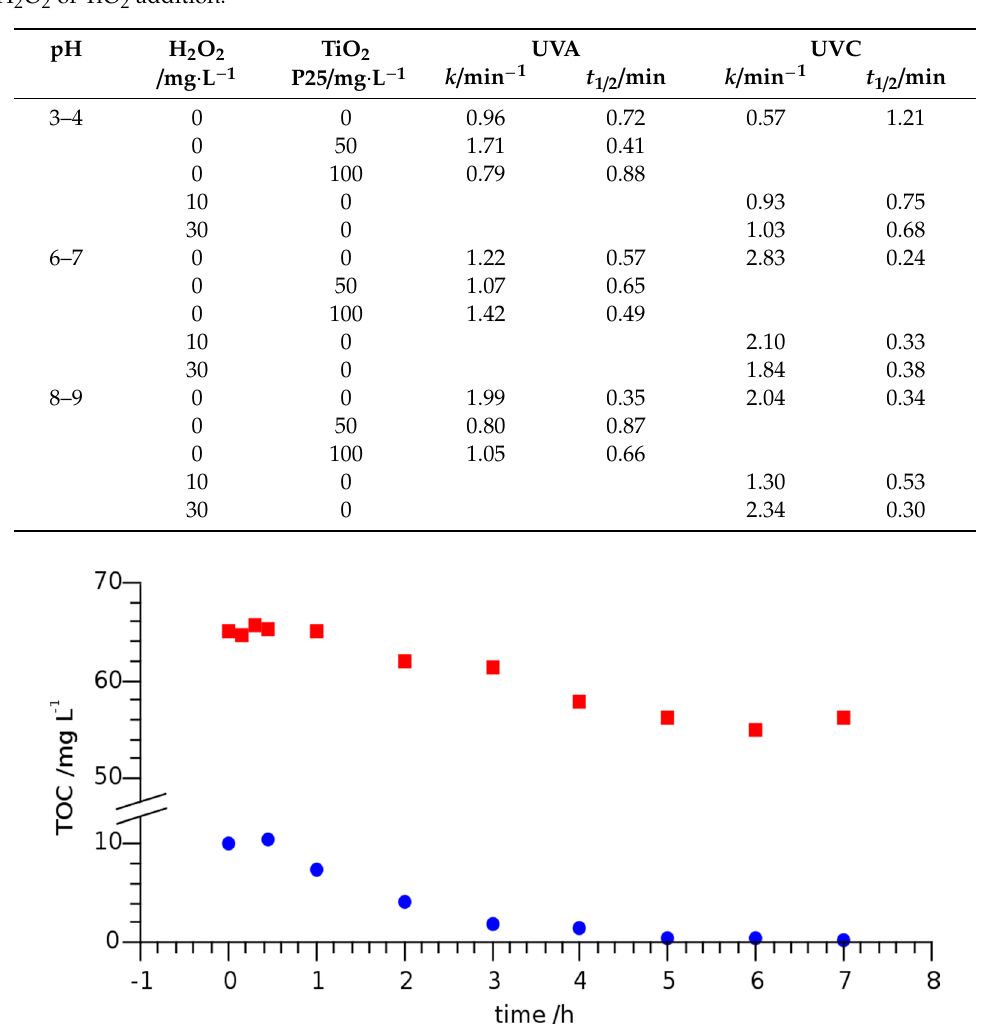
Table 3. Determined rate constants and the resulting half-lives with UVA and UVC irradiation and H 2 O 2 or TiO 2 addition .